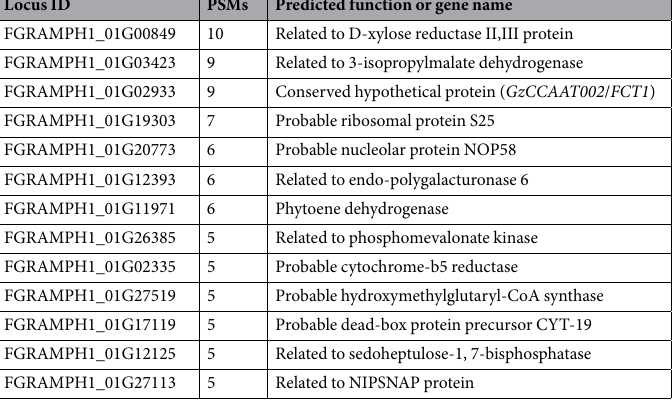
Table 2. Putative Fct2-interacting proteins identified via the affinity capture assay in Fusarium graminearum . PSMs, total number of identified peptide sequences (peptide spectrum matches) for the